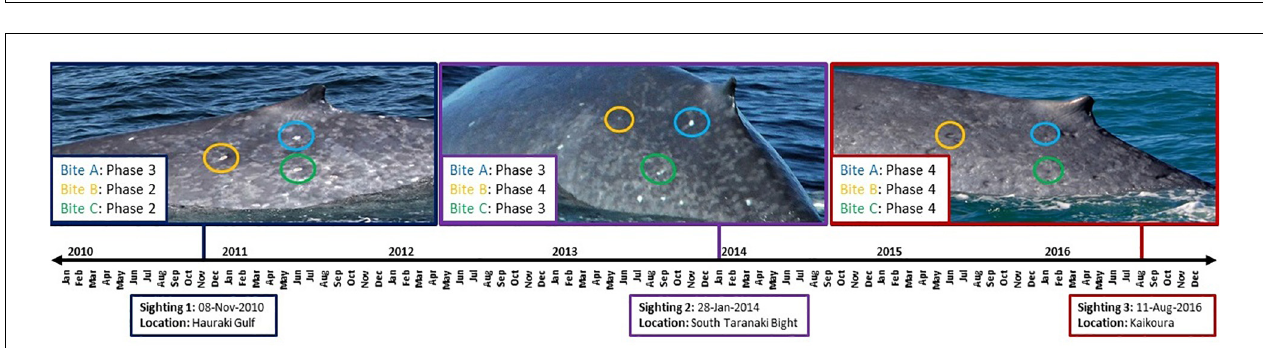
FIGURE 4 | Number of starburst lesions relative to (A) blister severity score, and (B) cookie cutter shark bite severity score. The number of starbursts represents the total count of starbursts within the assessment area for both sides, standardized by the percentage of the assessment area that was visible. Number of starbursts was log-transformed to account for skew toward zero.